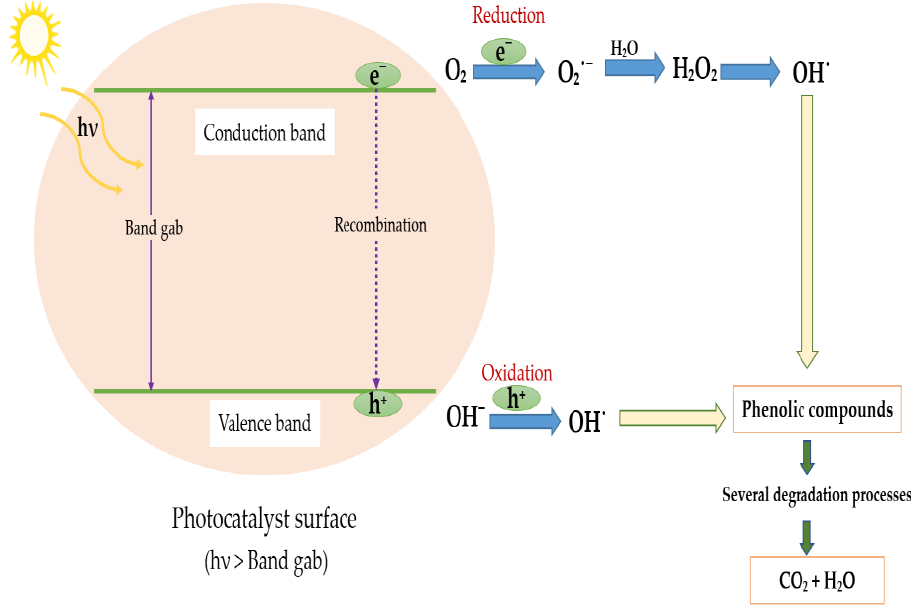
Figure 9. Schematic of the photocatalytic degradation